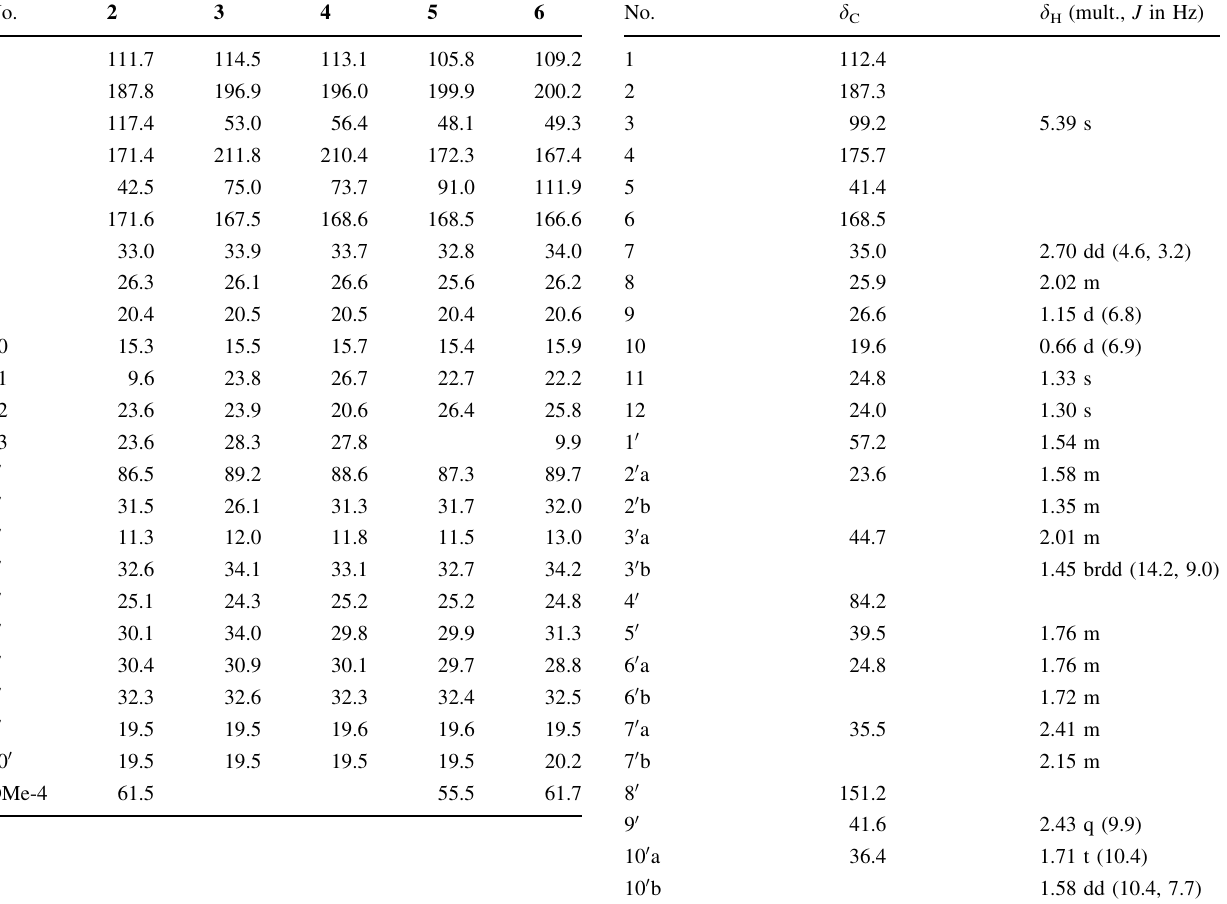
Table 3 13 C (125 MHz) NMR data of 2 – 6 in CDCl 3 No.